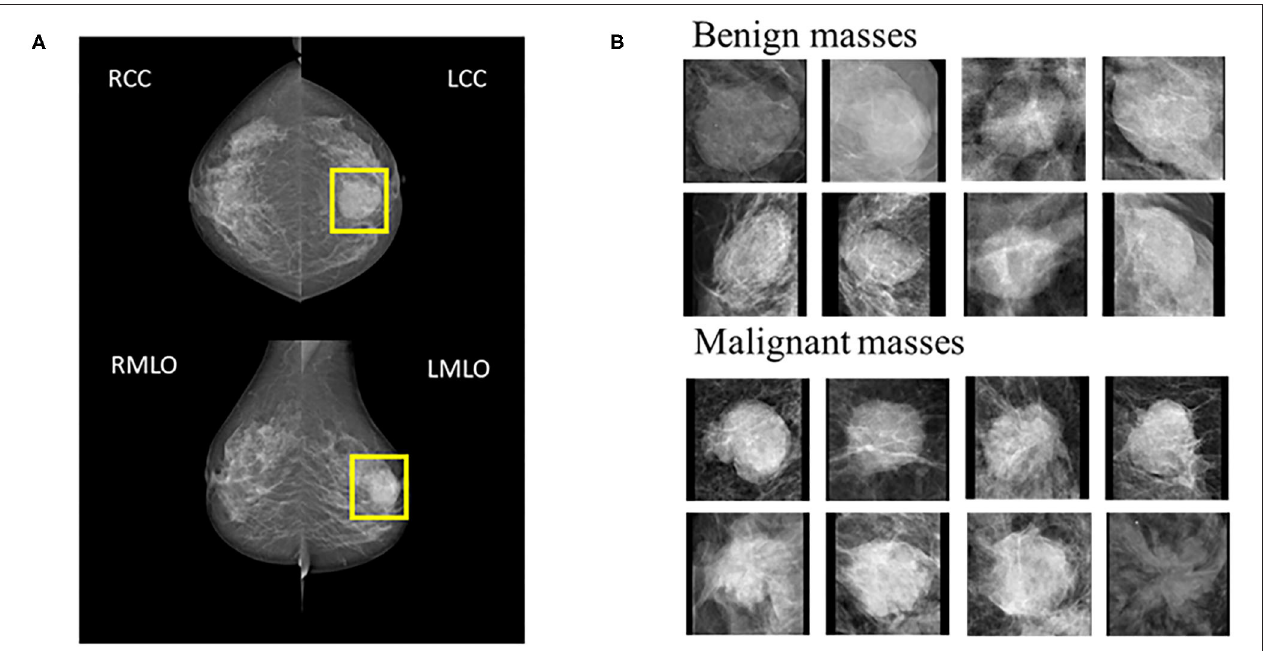
FIGURE 1 | (A) Example cases on CC and MLO views. The yellow square represents the suspicious area labeled by the radiologist. (B) 8 benign and 8 malignant masses.